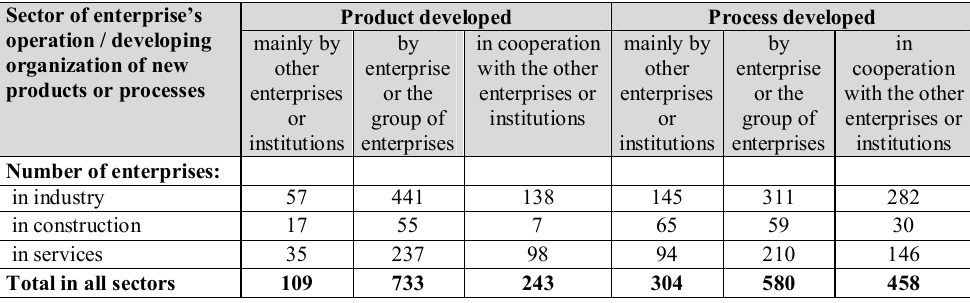
Table 2 - Product and process innovation according to the developing organization and the sector of its operation in Slovak